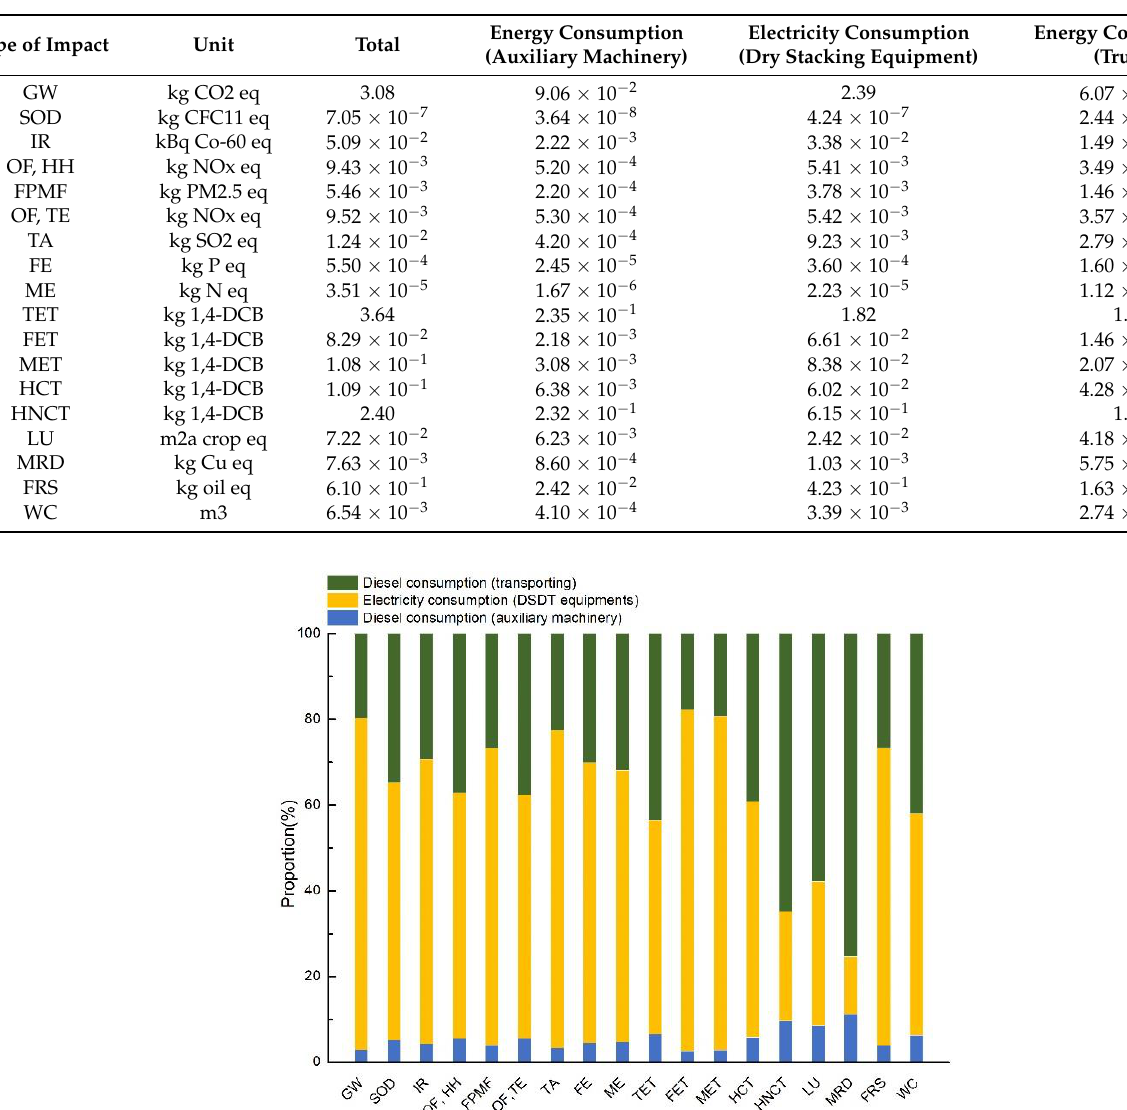
Table 6. Normalized LCA results for Scenario 3.